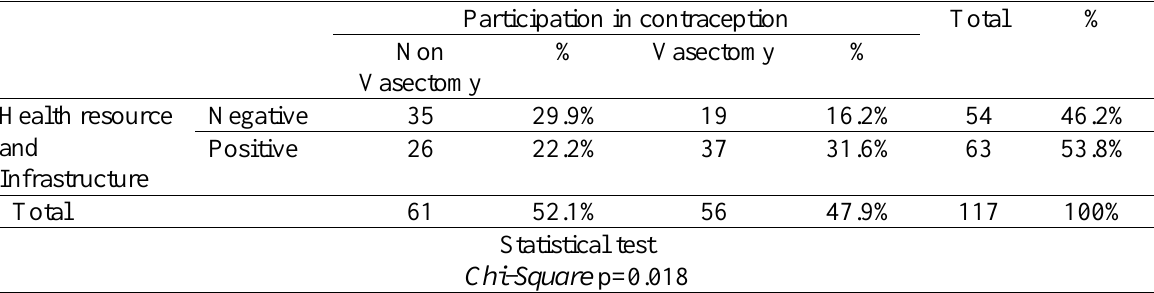
Table 5 The Correlation of health resources and infrastructure availability with vasectomy selection